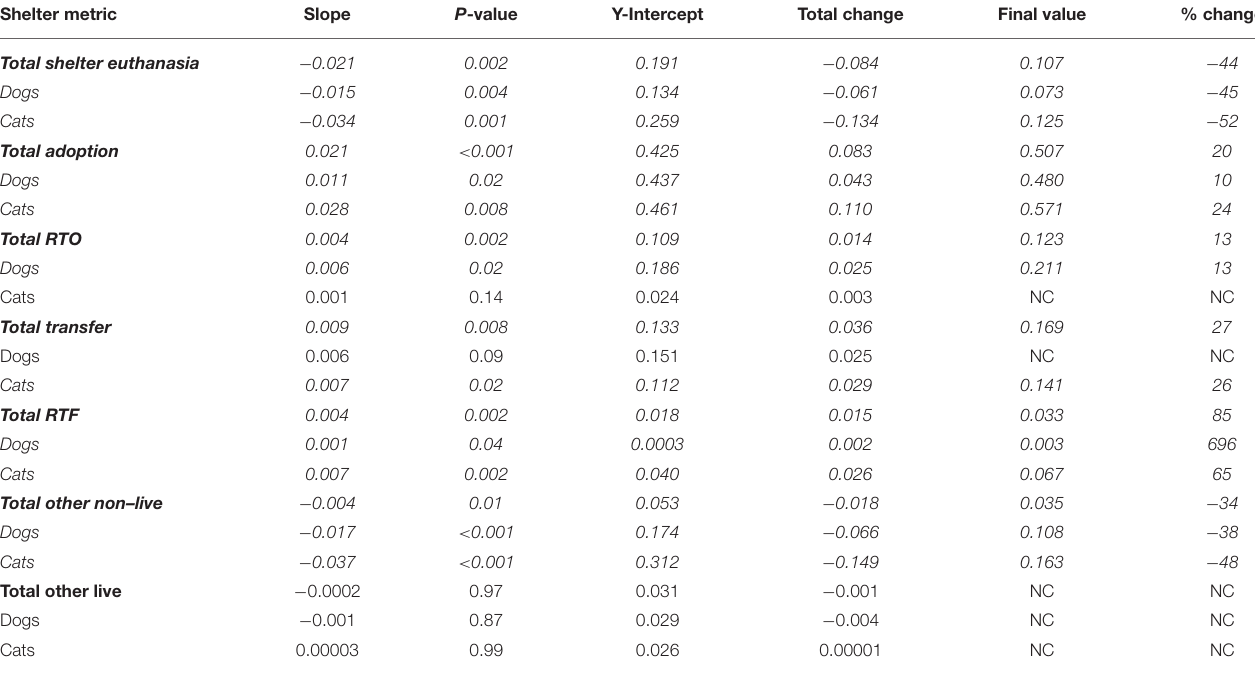
TABLE 2 | Results of linear regression analysis of outcomes as a percentage of intake reported by animal shelter organizations in the United States (2016–2020). Shelter metric Slope P -value Y-Intercept Total change